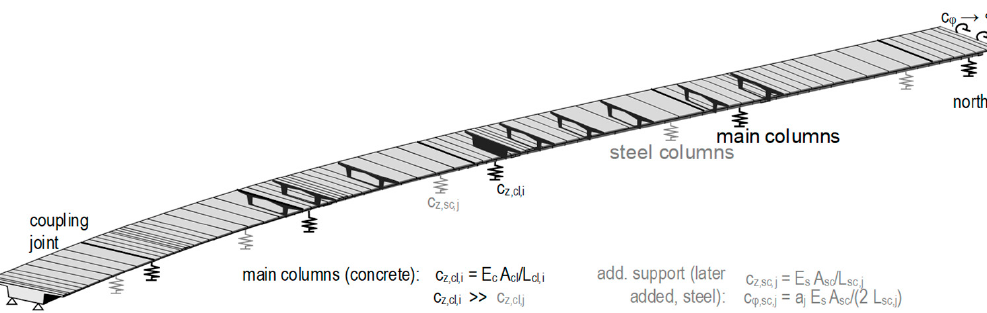
Figure 5. Finite-element model of the reference structure; beam elements (cross-sections for visualization) and boundary conditions by springs and supports.